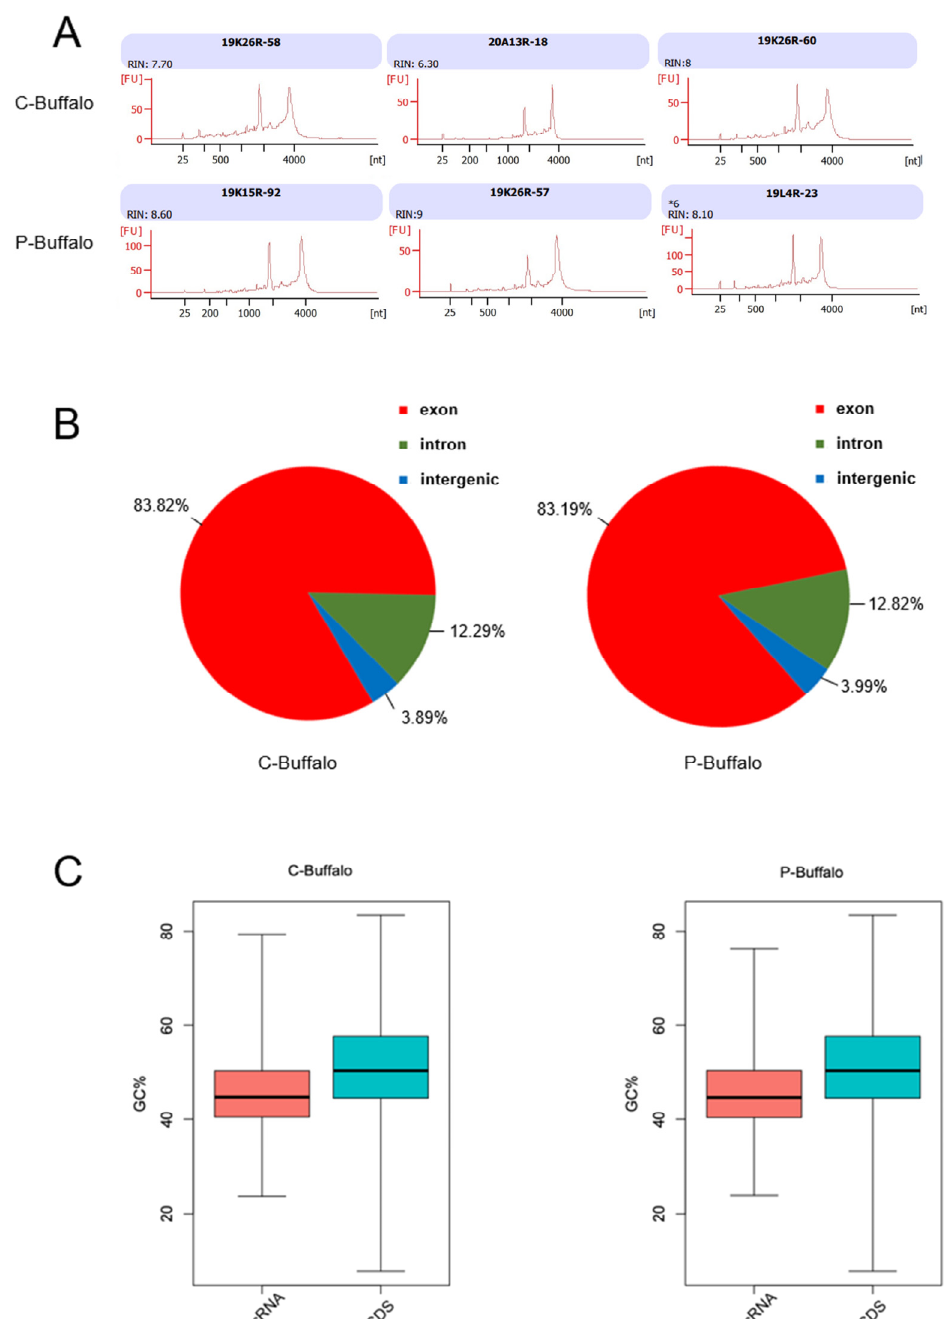
Figure 1. Characteristics of circRNAs expressed in the blood of Jianghuai buffalo. ( A ) Detection results of RNA quality in blood samples of Jianghuai buffalo. Total RNA was extracted from each group of blood samples and the Agilent 2100 Bioanalyzer was used to assess RNA integrity shown in the top and bottom graphs separately ( n = 3). ( B ) Genomic positions of circRNAs. Genomic profiles with commonly encountered circRNAs being shown in venous blood of C-Buffalo and P-Buffalo are displayed in the left and right panels, separately. ( C ) The GC content of circRNAs and mRNAs. Total GC amount in circRNAs and mRNAs for expression in C-Buffalo and P-Buffalo is displayed in the left and right panels.